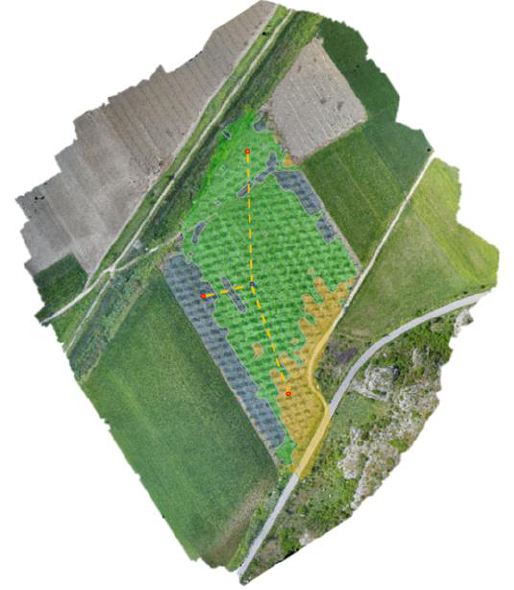
Figure 7. The 3D point cloud as depicted at farmB.eye module based on the aerial images acquired by the UAS flying at altitude of 50 m over the orchard.